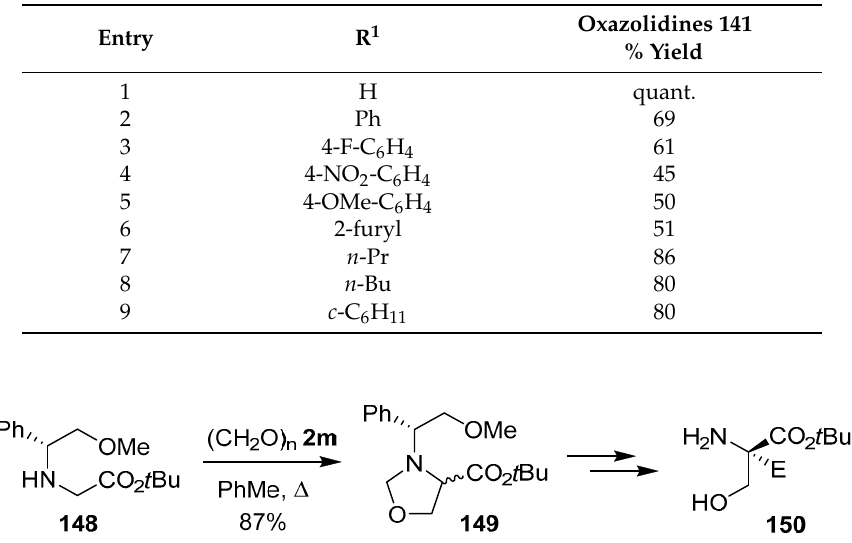
Table 20. Cycloaddition of azomethine ylide 140 to aldehydes 2 (Scheme 35).